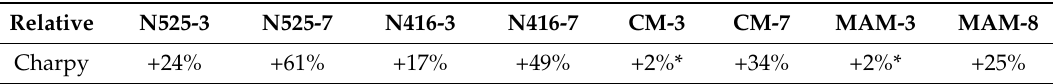
Figure 8. Charpy impact strengths with standard deviations. Table 4. Impact strengths relative to the reference (NC). Differences not significant at the 95% confidence level are marked with an asterisk (*).